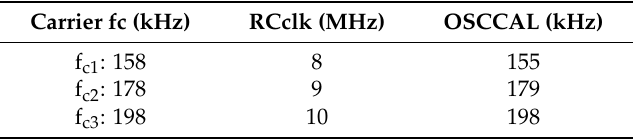
Table 3. Carrier frequencies for mutual-capacitance